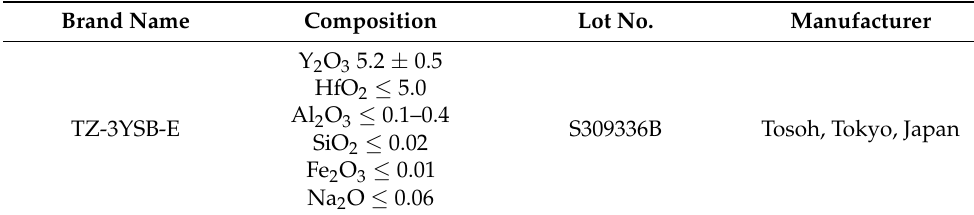
Table 1. Material information for 3Y-TZP utilized in the present study